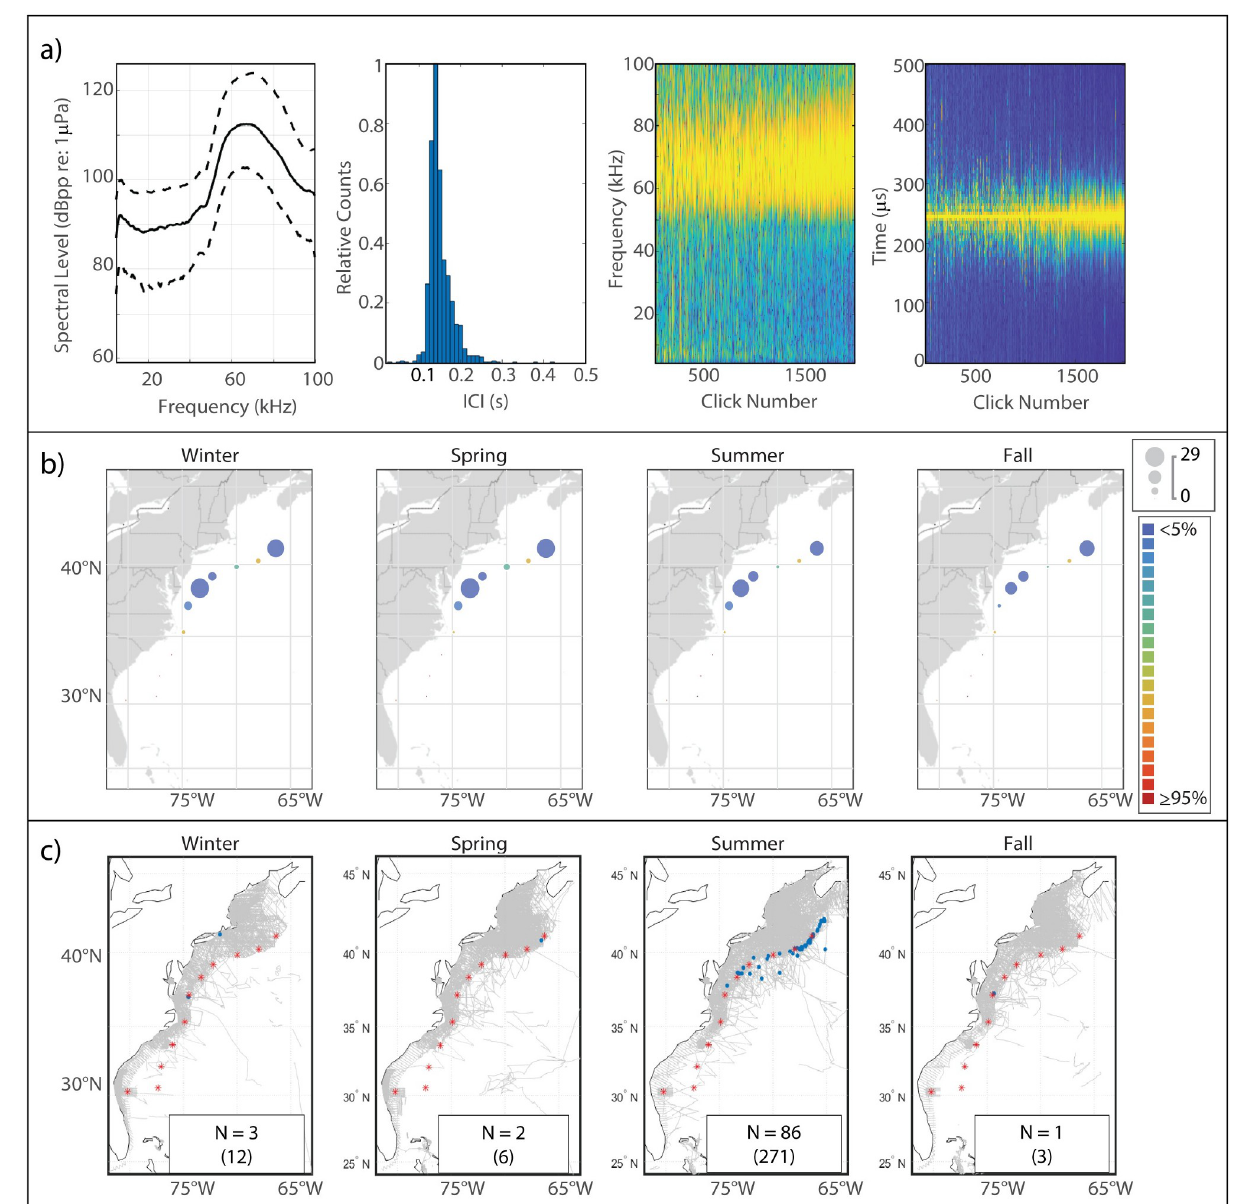
Fig 3. Results for Sowerby’s beaked whale showing click type (a), acoustic presence (b), and historical sightings (c). Subplots as in Fig 2.